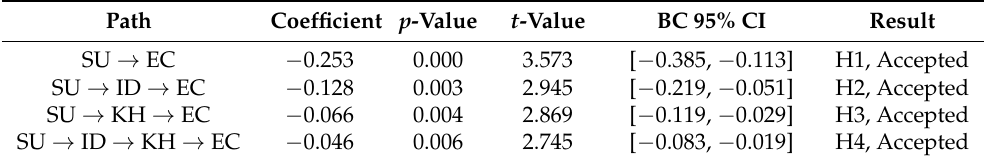
Table 3. Direct and indirect effects of social undermining on employee creativity. Path